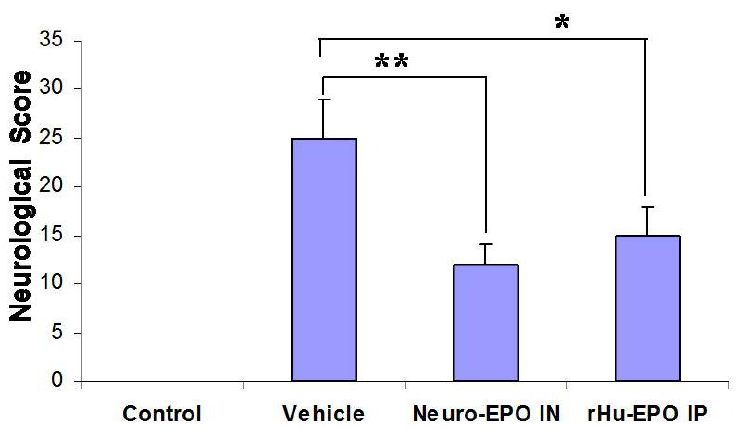
FIGURE 2 . Neurological score in the pattern of permanent occlusion of the right carotid in Mongolian gerbils. Asterisk indicates a significant difference (* p <0.05; ** p < 0.01) (n = 35 for